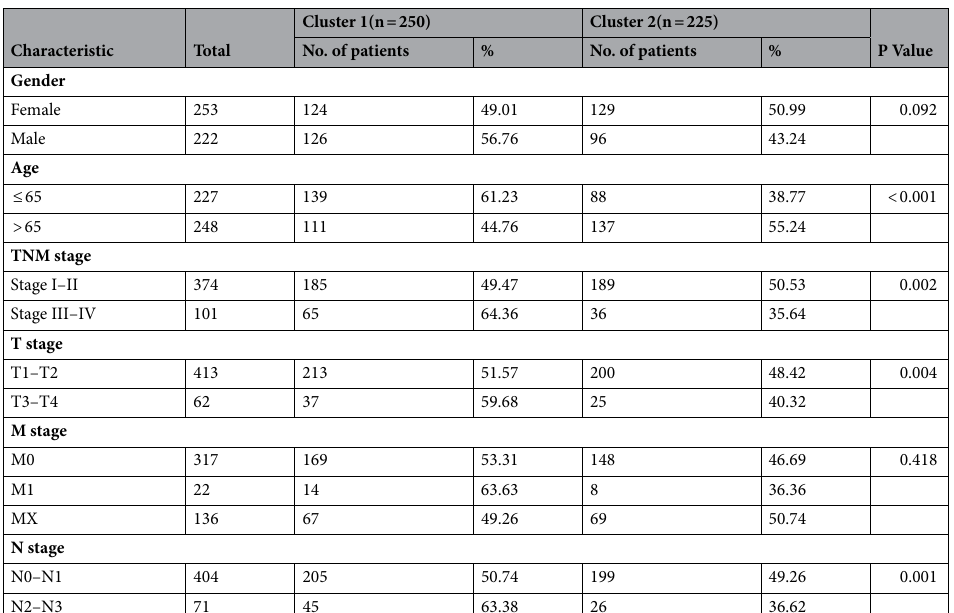
Table 1. Clinicopathological characteristics of cluster 1 and cluster 2 in LUAD